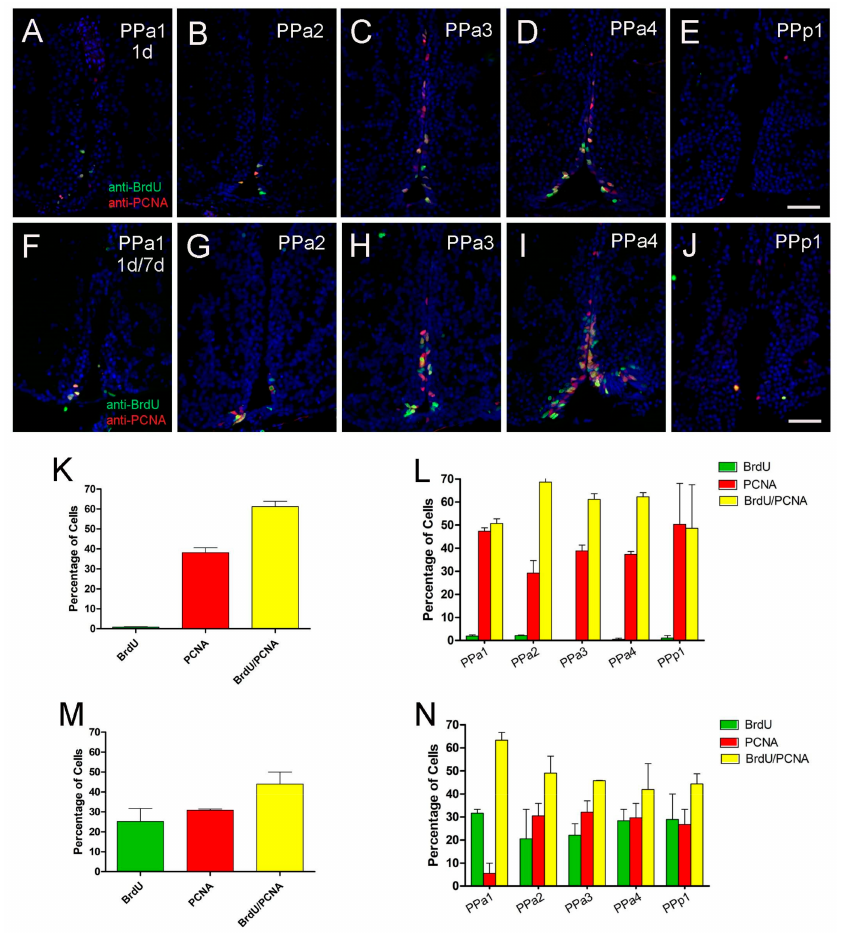
Figure 5. POA generates new cells with 8-day pulse-chase labeling. ( A – J ) BrdU/PCNA double immunofluorescence in transverse paraffin sections of 5 µ m. ( A – E ) Treatment with one pulse of BrdU on day 1 and brains fixed on the second day. ( F – J ). Treatment with two pulses of BrdU at 1 and 7 days, and brains were fixed at day 8. All sections were labeled with DAPI (blue). Scale bar: 30 µ m. ( K , M ) Percentage of cells double or single labeled for BrdU or PCNA located in the POA, with single-BrdU pulse on day 1 ( K ) and two BrdU pulses at 1 and 7 days ( M ). ( L , N ) Percentage of cells double or single labeled for BrdU or PCNA in representative sections of the POA with single-BrdU pulse on day 1 ( L ) and two BrdU pulses at 1 and 7 days ( N ). For each representative region of the POA, the number of sections ( L ) (PPa1 = 5, PPa2 = 10, PPa3 = 13, PPa4 = 12, and PPp1 = 4) and ( N ) (PPa1 = 5, PPa2 = 10, PPa3 = 13, PPa4 = 12, and PPp1 = 4) labeled, BrdU + , PCNA + and BrdU + /PCNA + cells were counted. Graphs plotted with